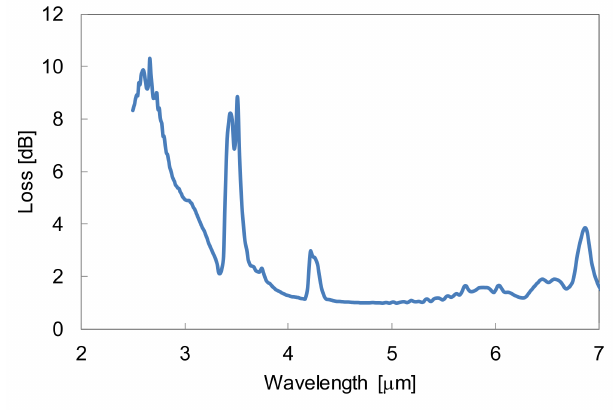
Figure 3. An attenuation loss spectrum of hollow optical fiber with an inner cyclic olefin polymer (COP) film. The inner diameter of the fiber is 700 µ m and the length is 120